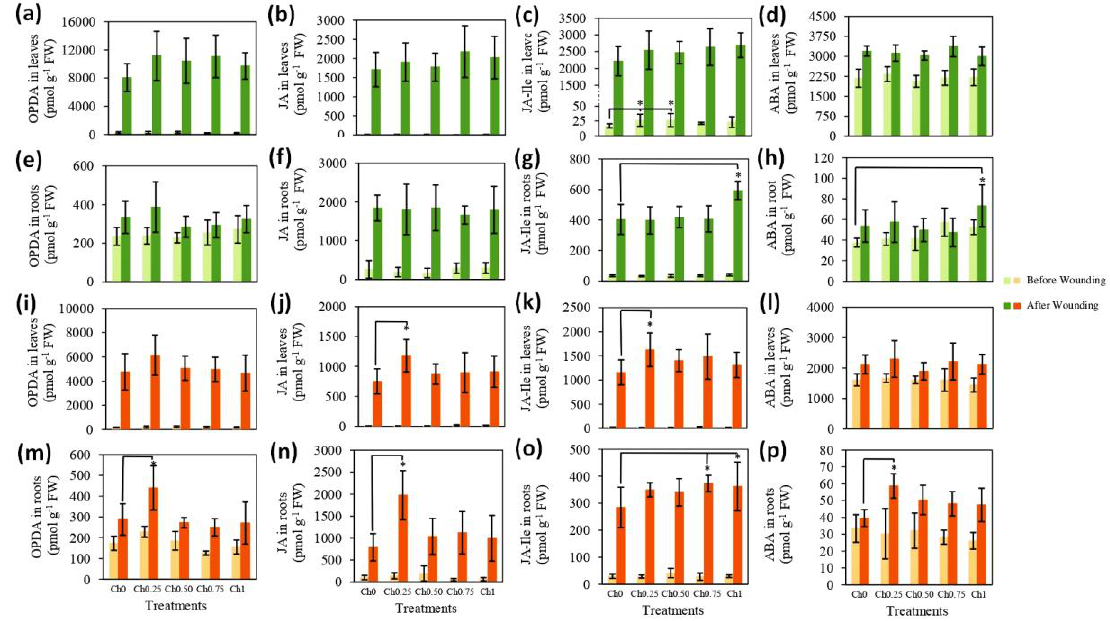
Figure 4. Changes in the levels of plants ’ defense hormones after chitosan application to shoots ( a – h ) and to roots ( i – p ) +/ − wounding stress. Means ± SD, n = 4. * indicates significant differences between treatments following one-way or two-way ANOVA (Duncan’s multiple range, p ≤